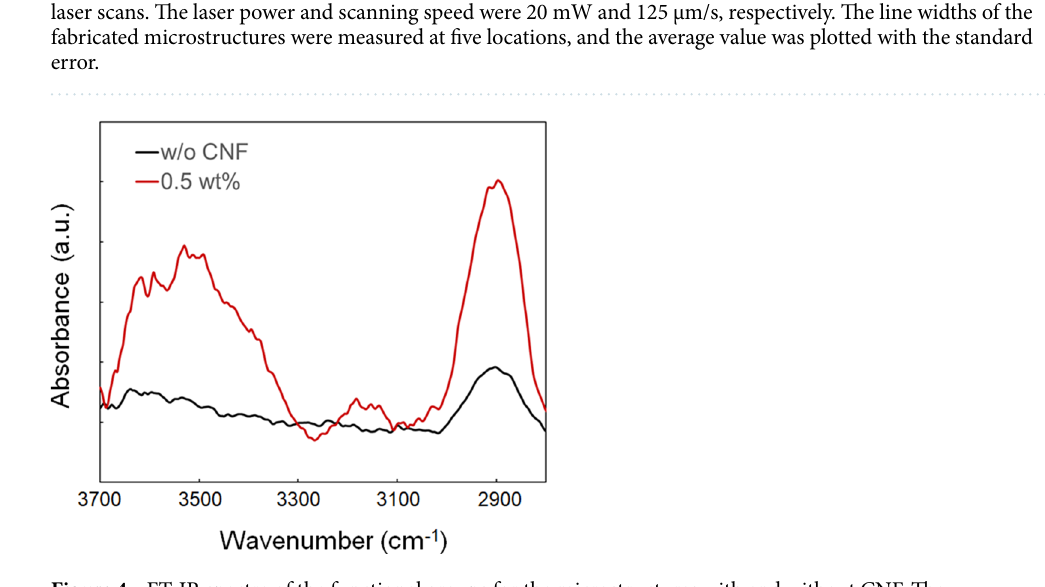
Figure 4. FT-IR spectra of the functional groups for the microstructures with and without CNF. The concentration of the CNF was 0.5 wt% for the microstructure with